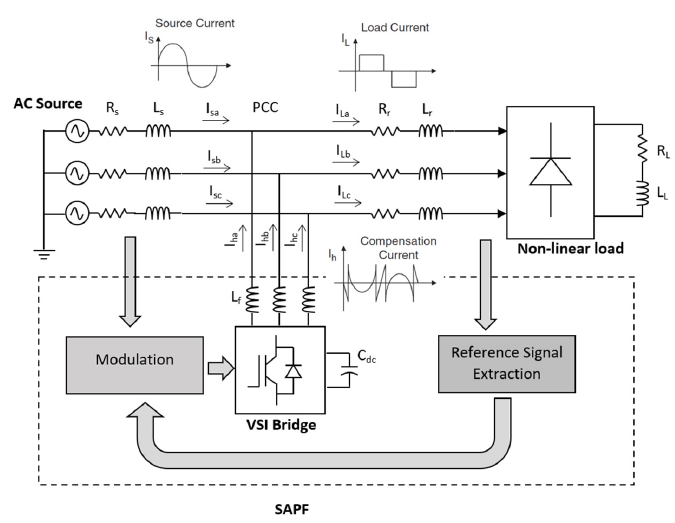
Figure 1. Three phase shunt active power filter Block Diagram.